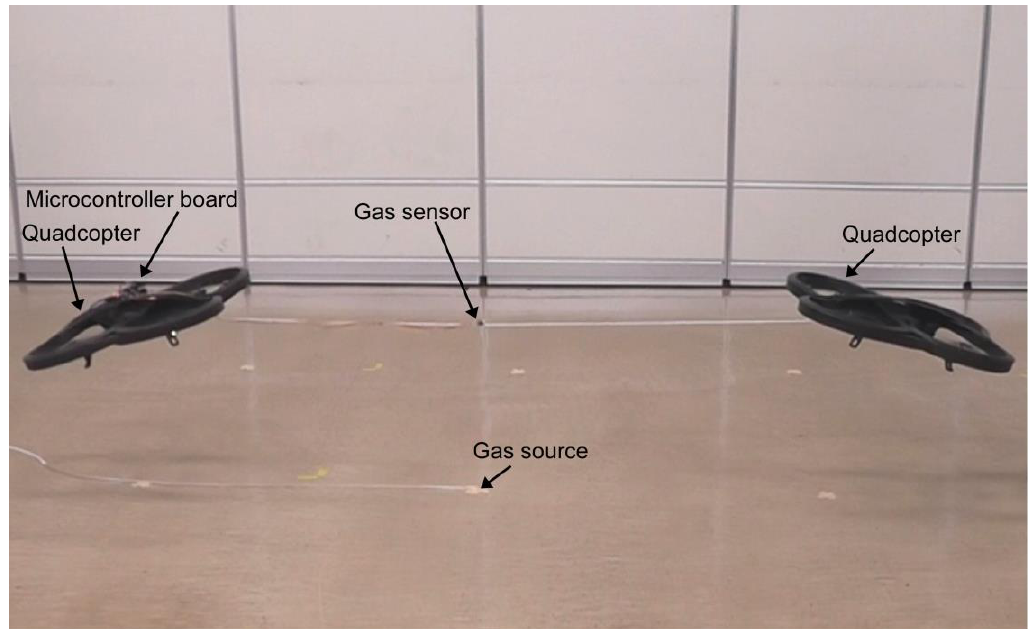
Figure 2. Quadcopters flying over a gas source. Two quadcopters were connected using a polypropylene string. A metal oxide gas sensor was attached at the midpoint of the string. A plastic tube was fixed on the floor using adhesive tape, and ethanol vapor was released from its tip.